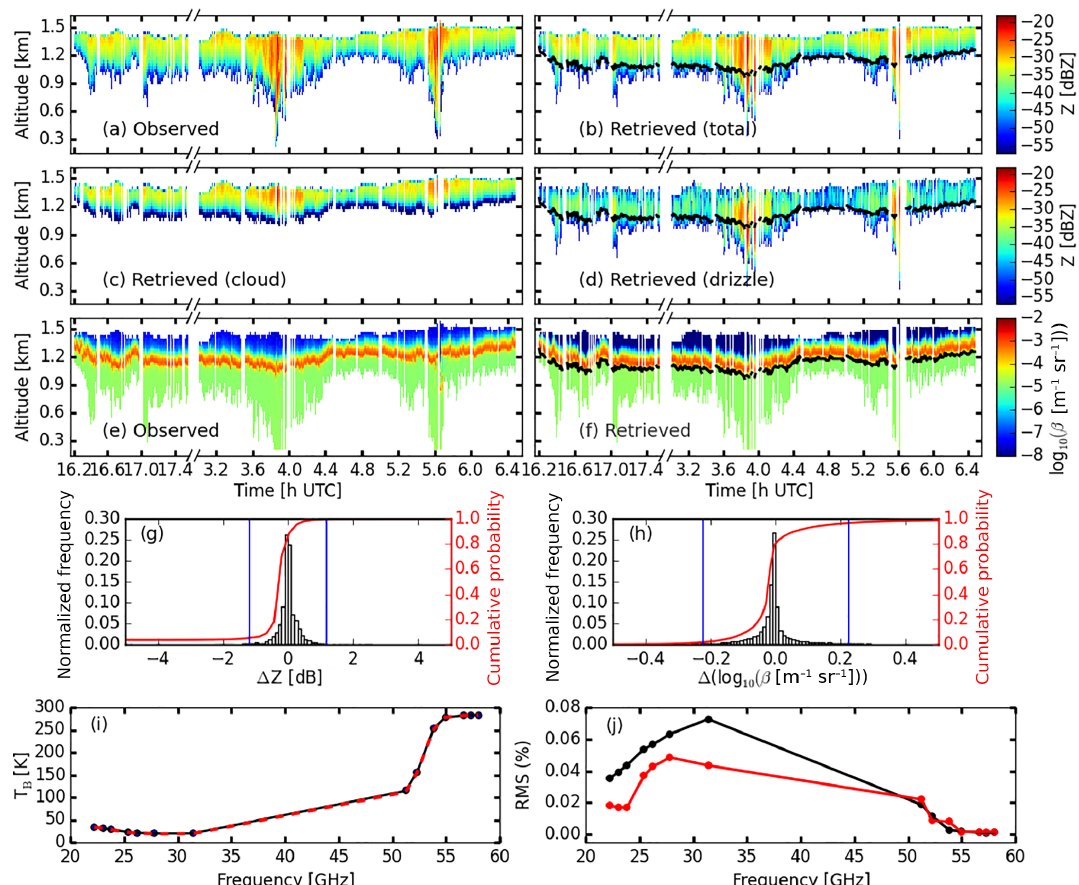
Figure 7. Measured and retrieved signals of the selected cases from the ACCEPT campaign. The breaks along the horizontal axes in (a) – (f) mark the change of date from 25 to 26 October 2014. Panels (a) – (d) show the radar reflectivity as observed and as retrieved, along with the decomposition into drizzle and cloud reflectivities. The black line delineates the cloud base determined in the retrieval. Panels (e) – (f) display the observed and the retrieved attenuated lidar backscatter β . Panels (g) and (h) : histograms of the differences between the observed and the retrieved (total) signals (observed minus retrieved). The red curves show the cumulative distributions. The spread of the distribution is indicated by the blue vertical lines that mark the interval within which 95% of the total occurrences are found. Panel (i) shows the brightness temperatures T B averaged over distance at each frequency channel: the black circles and line show the observations while the dashed red line shows the retrieval. In (j) we plot the standard deviation of the observation mean divided by the mean itself (black) and the RMSD between the retrieval and the observation divided by the observation mean